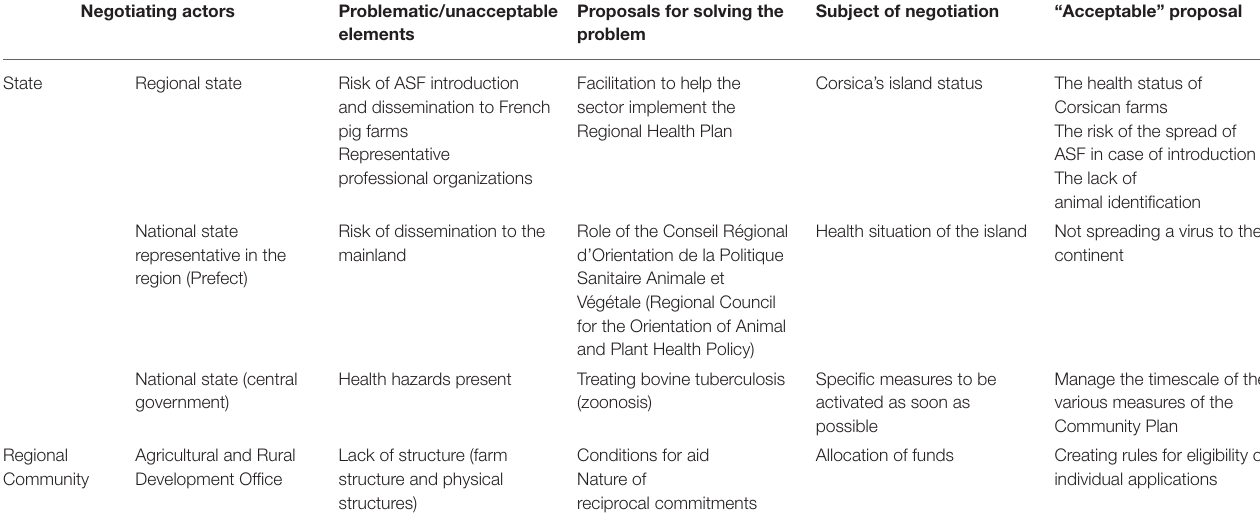
TABLE 4 | Positions of local and national authorities in the regional health plan negotiations in the territorial preparedness process against ASF in Corsica